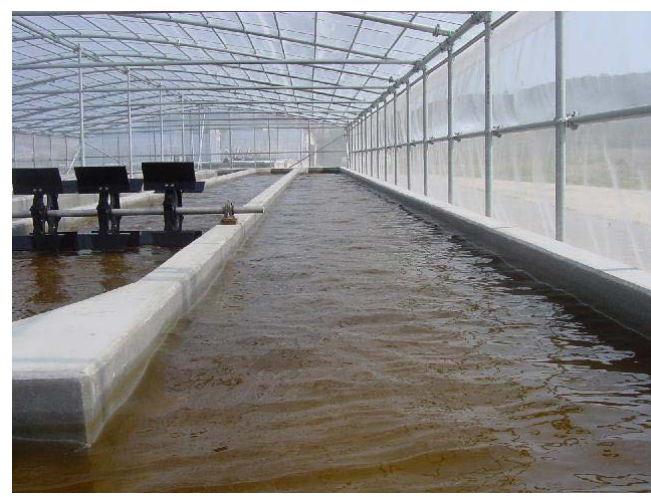
Figure 2. Raceway pond used for cultivation of P. carterae on Miyako Island, Okinawa, Japan.